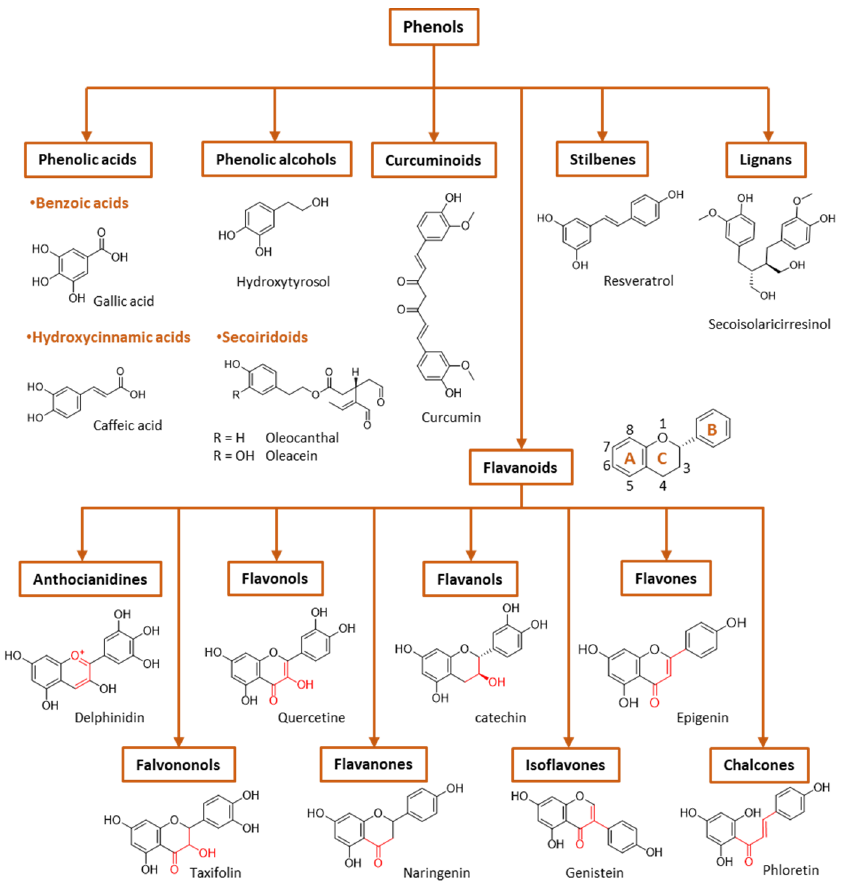
Figure 3. General classification of polyphenols.